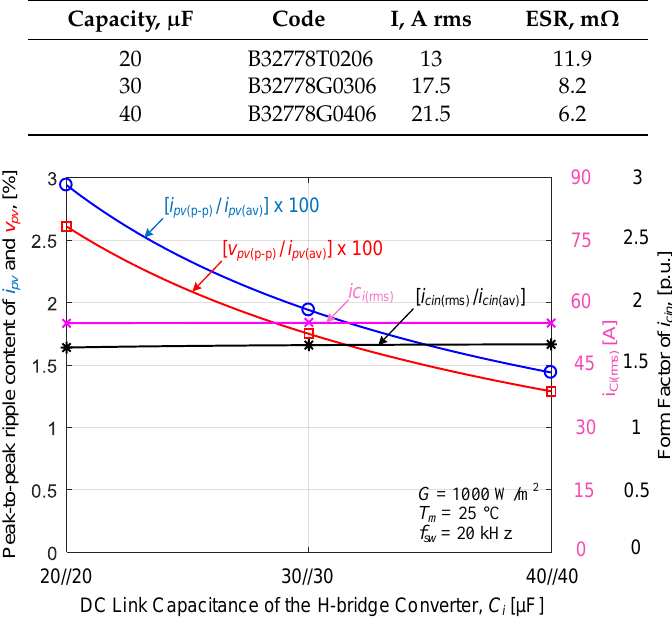
Figure 12. The variations in peak-to-peak ripple contents of i pv and v pv , i ci ( rms ) , and form factor of i cin against DC link capacitance of H-bridge converter for standard test conditions (these theoretical results were obtained using the dynamic model in Figure 5b; f sw = 20 kHz assumed).